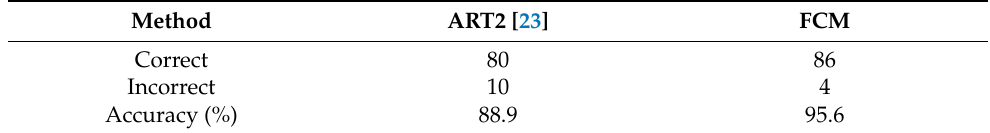
Table 3. Accuracy of Cyst Extraction.